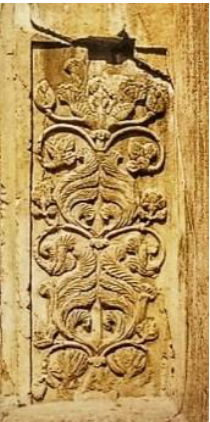
Figure 15. Taq-e Bostan, Giovanni Curatola, John Roberto, Gianroberto Scarcia, 2015